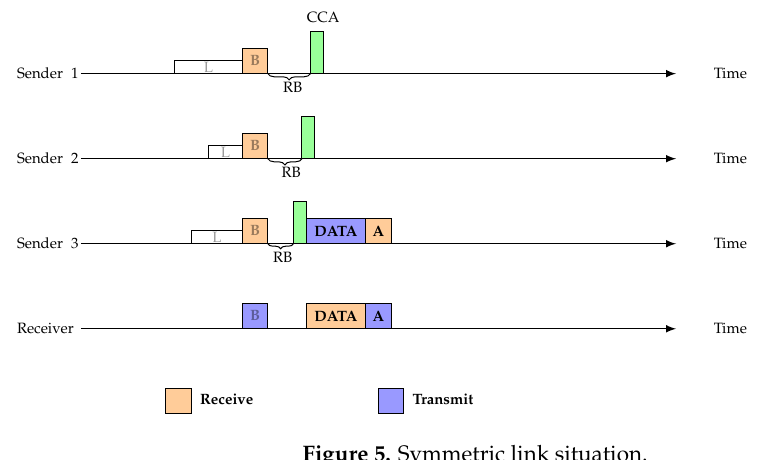
Figure 5. Symmetric link